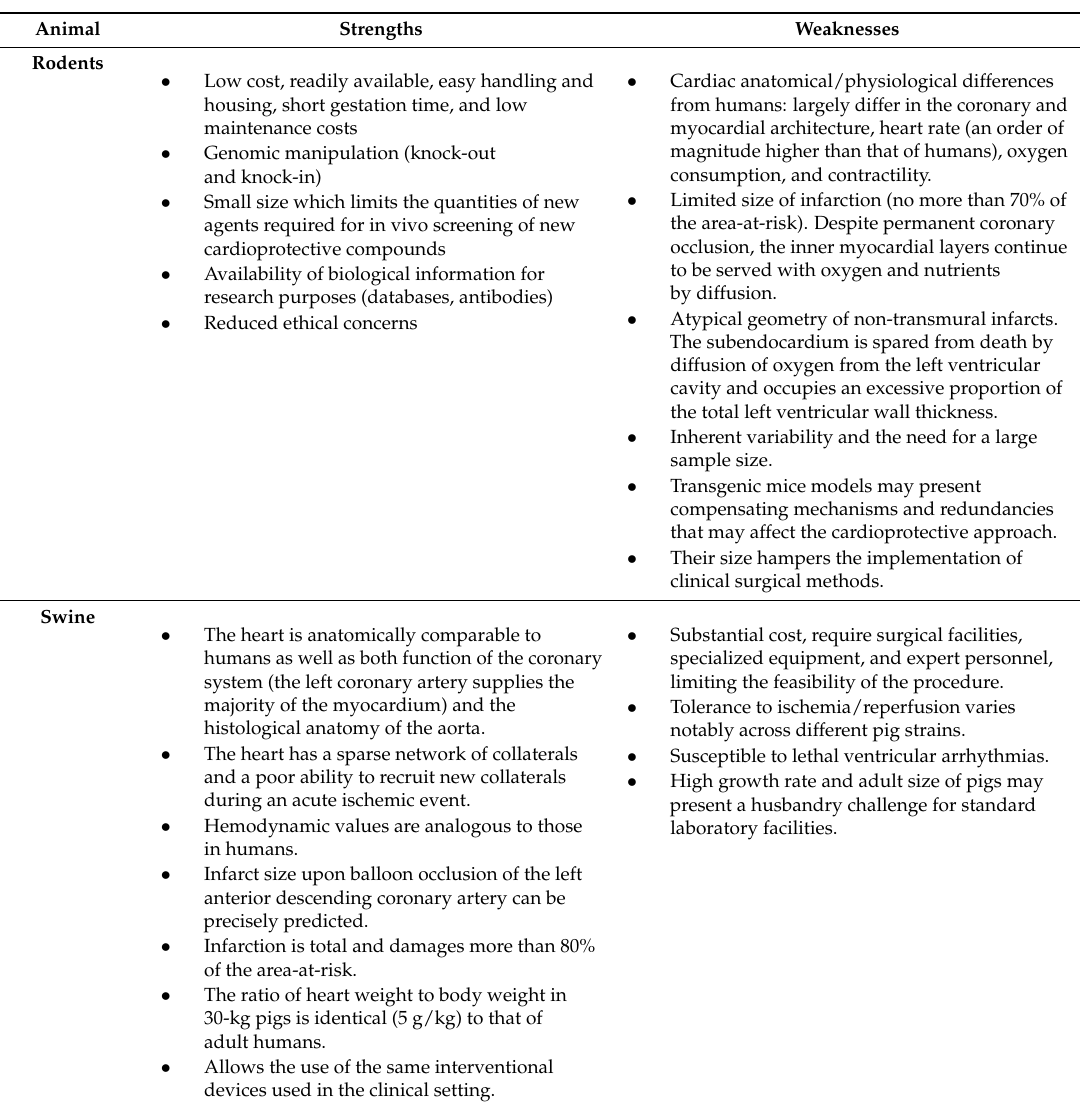
Table 1. Strengths and weaknesses for conducting cardioprotection-related studies in the most commonly used animal models of myocardial